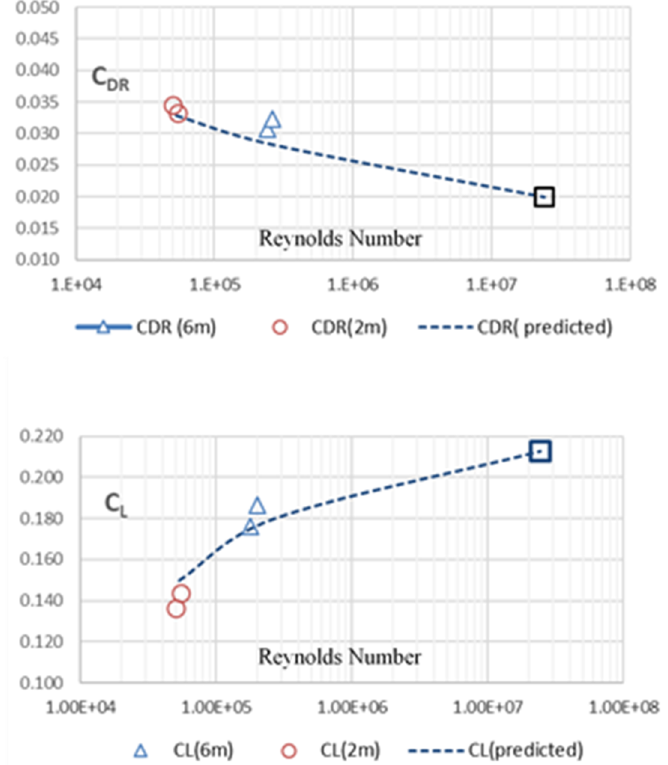
Figure 12. Gate rudder blades drag coefficient, C DR , (top) and lift coefficient, C L , (bottom) obtained with two different size models.